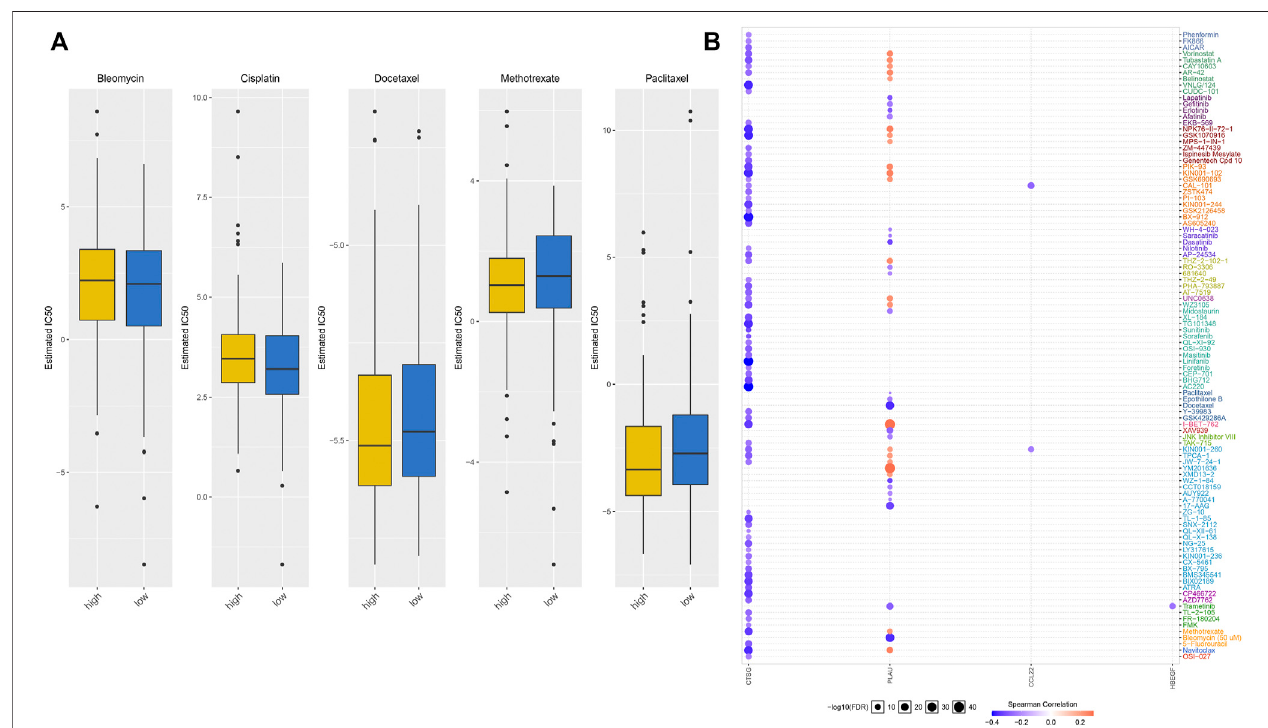
FIGURE 9 | IRS predicts anticancer drug responses of OSCC patients. (A) Comparisons of IC50 values of chemotherapeutic agents in high- and low-risk groups. (B) Spearman correlation analysis of the correlations of each characteristic IRG with IC50 values of anticancer drugs.